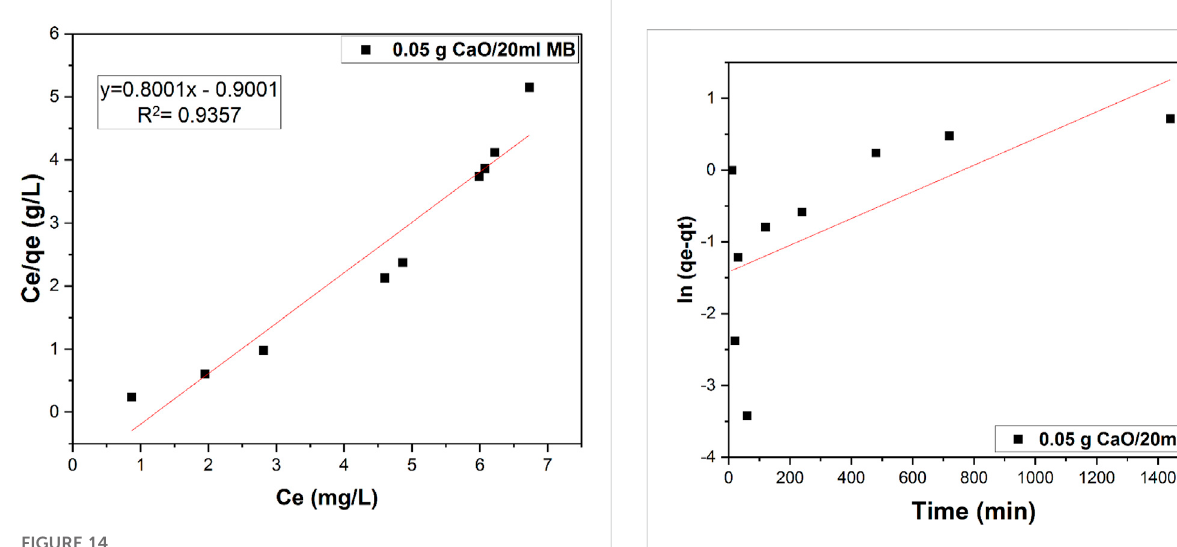
FIGURE 16 First-order kinetic model plot of 0.05 g/20 ml MB